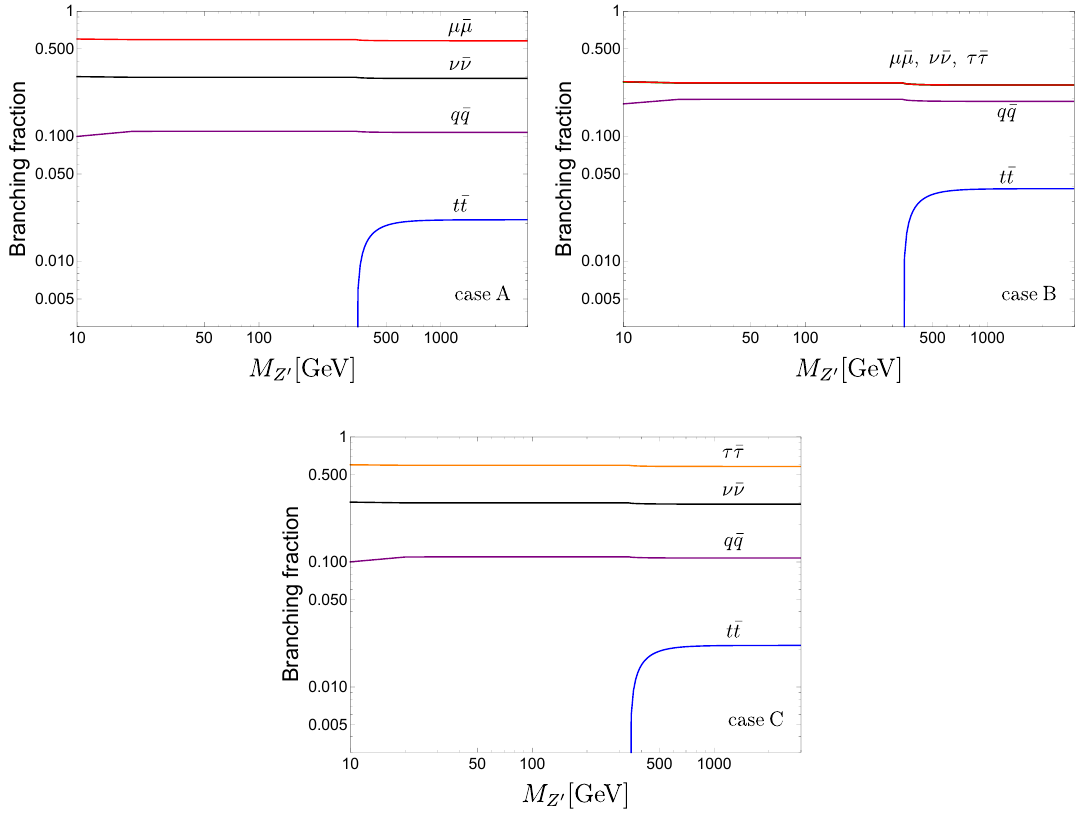
Figure 1. The branching fractions of Z 0 for Case A (upper right), B (upper left), and C (bottom), with q = f u; d; c; s; b g